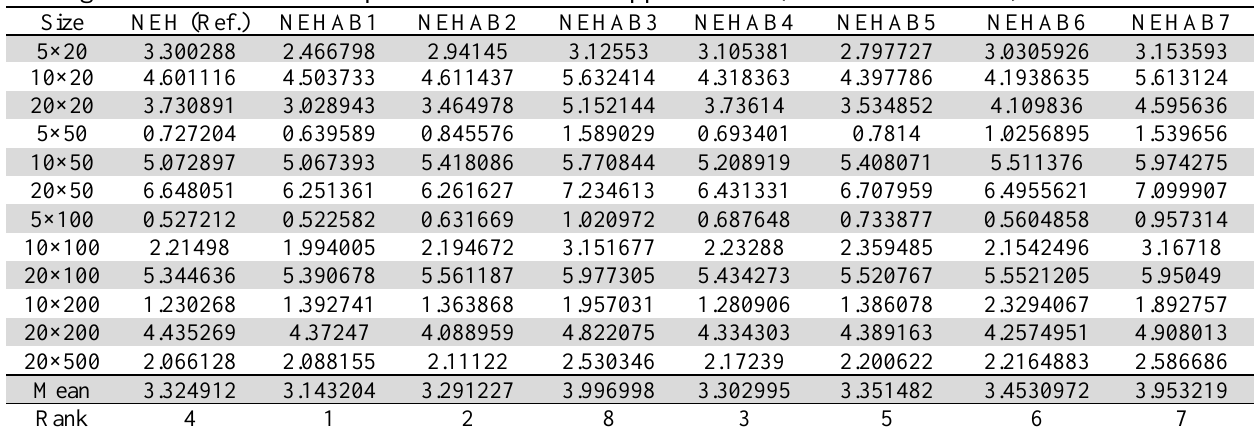
Average % increase in Makespan from the known upper bound (Relative Deviation) Size NEH (Ref.)